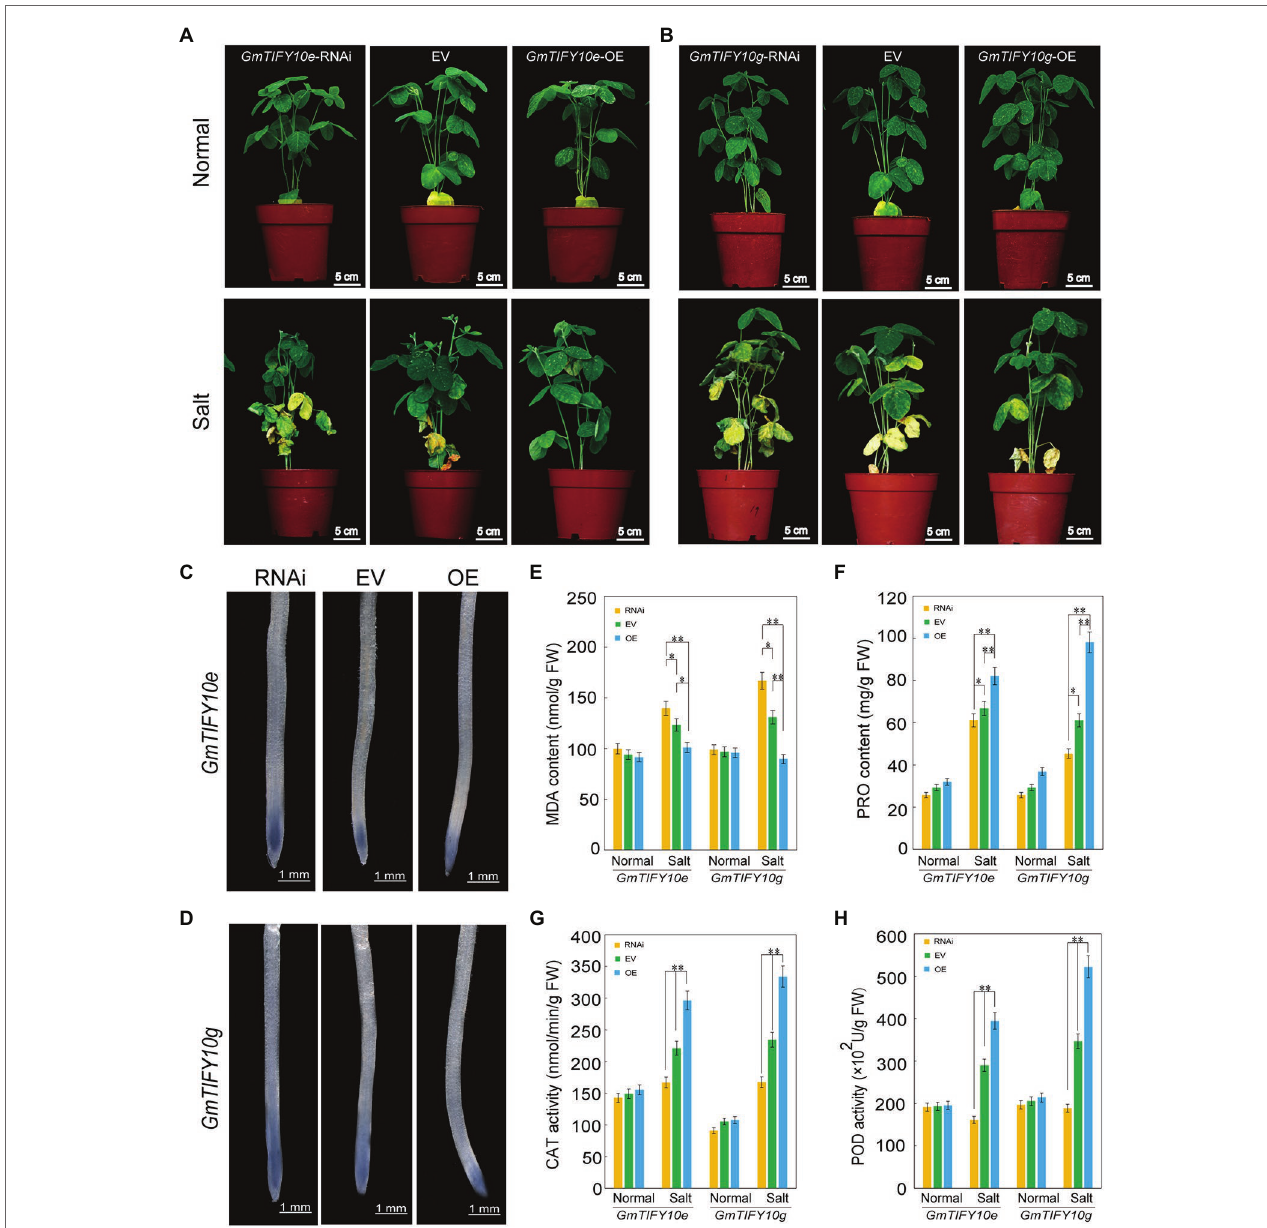
FIGURE 10 | Analysis of the function of soybean GmTIFY10e and GmTIFY10g under normal and salt stress. (A,B) Phenotype analysis of EV and transgenic plants under normal and salt stress. The scale bar indicates 5 cm. (C,D) NBT staining of EV and transgenic plant roots under salt stress. The scale bar indicates 1 mm. (E–H) The MDA (E) , PRO (F) , CAT (G) , and POD (H) contents of EV and transgenic plant leaves under normal and salt stress. The data are shown as the means ± SD obtained from three biological replicates. ANOVA test demonstrates that there are significant differences compared with EV ( * p < 0.05, ** p <